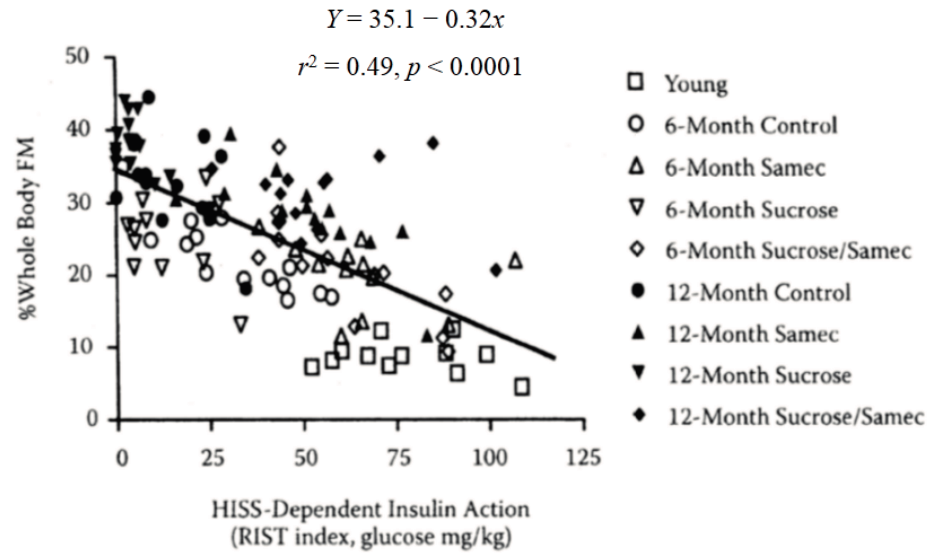
Figure 9. Adiposity can be predicted from HISS action, shown by pooled data from normal aging rats (9 weeks, 6 months, and 12 months), age plus sucrose, age plus antioxidant (Samec), and age plus sucrose plus antioxidant (Samec). Whole-body fat mass (FM) was estimated from bioelectrical impedance but the relationship is similar for adiposity determined by measuring regional adiposity on the basis of weighed fat mass from perinephric, perienteric, and epididymal fat pads. As HISS action decreases, adiposity increases. Results were recalculated from data in Lautt et al. 2008 [59] and Ming et al. 2009